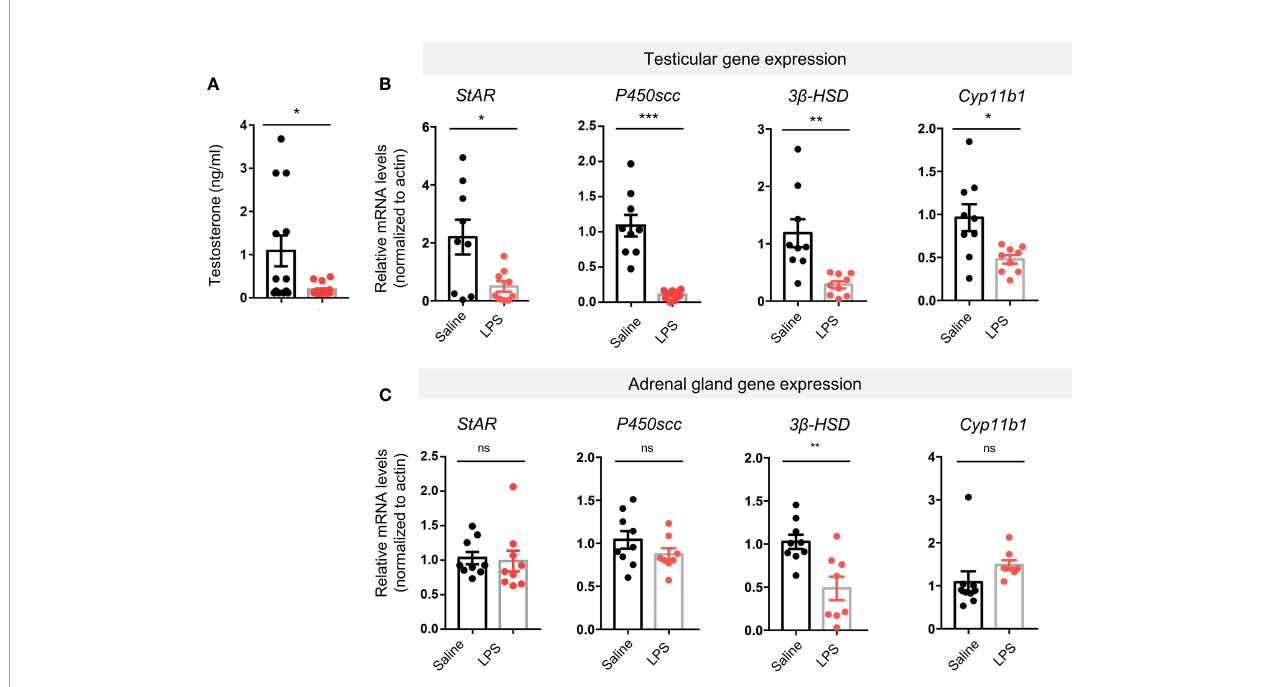
FIGURE 3 | LPS treatment resulted in decreased levels of plasma testosterone and testicular steroidogenesis-regulating proteins gene expression. (A) The LPS- treated group had lower plasma testosterone levels compared with saline controls (data are presented as mean ± SEM, n = 13 saline, n = 16 LPS; Student ’ s t-test, *p < 0.05). (B, C) Real-time quantitative PCR results showed LPS treatment resulted in lower gene expression levels of steroidogenic acute regulatory protein ( StAR ), cholesterol side-chain cleavage enzyme ( P450scc ), 3 b -hydroxysteroid dehydrogenase ( 3 b -HSD ), and cytochrome P450 family 11 subfamily B member 1 ( Cyp11b1 ) compared with controls. In adrenal glands of the LPS-treated mice, no signi fi cant changes in the steroidogenesis-regulating proteins gene expression were observed except for 3 b -HSD (data are presented as mean ± SEM, n = 9 saline, n=8-9 LPS, Student ’ s t-test, ***p < 0.001, **p < 0.01, *p < 0.05, ns, p >